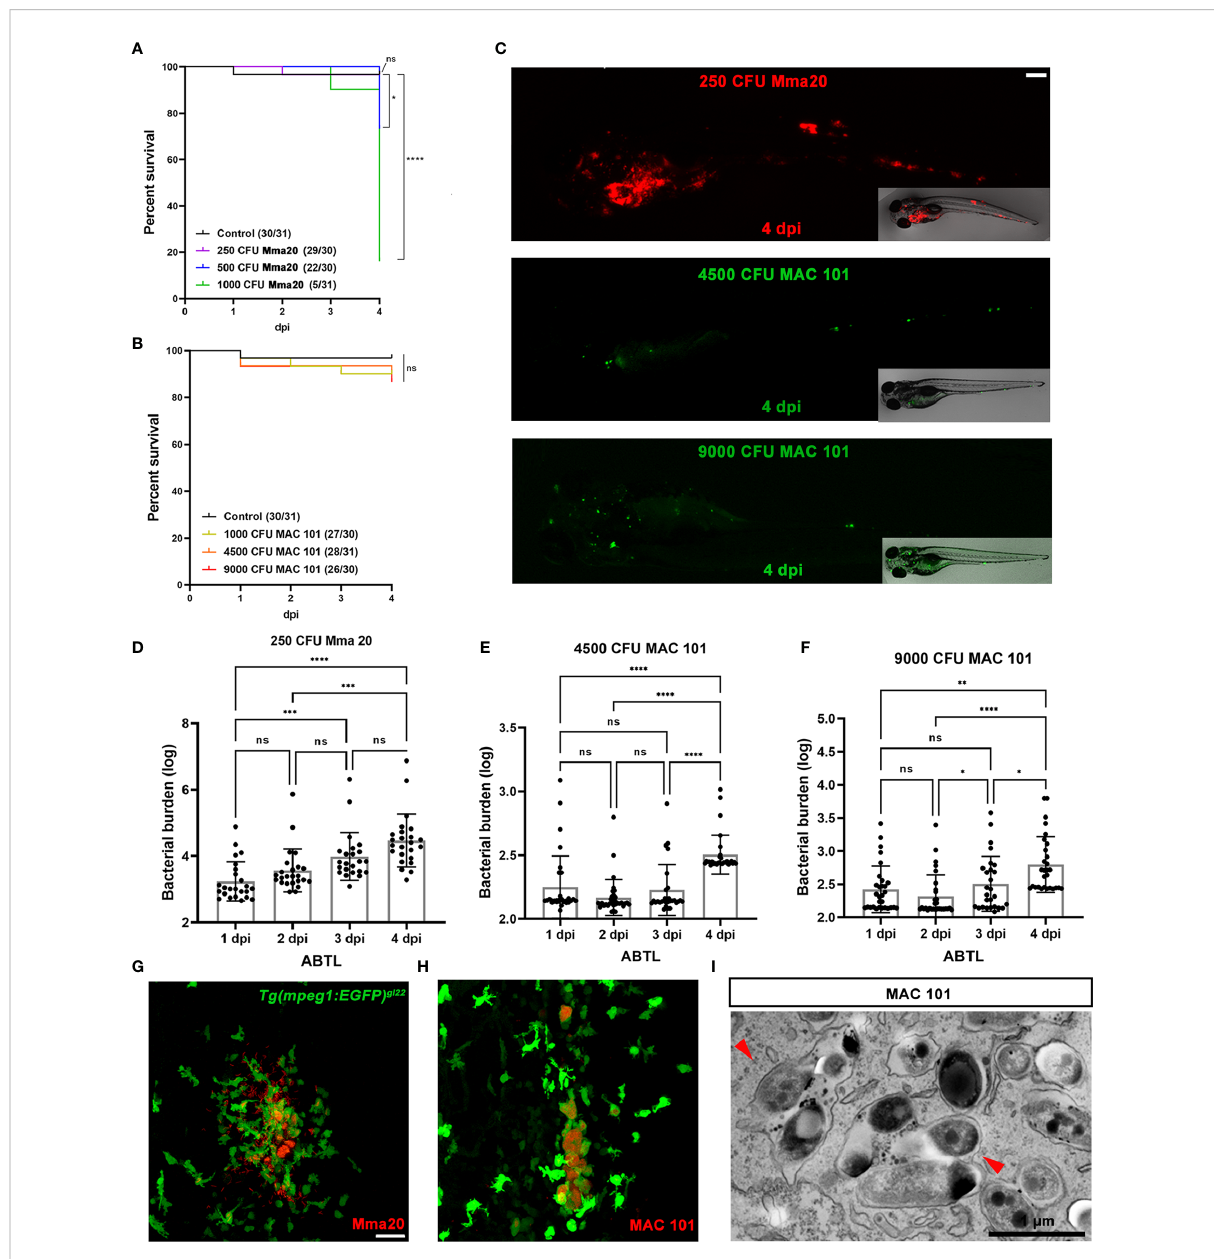
FIGURE 1 Characterization of M. avium infection in zebra fi sh larvae compared to M. marinum infection. (A, B) Percent of survival curves for ABTL zebra fi sh larvae infected with a series of doses M. marinum Mma20 or M. avium MAC 101. ABTL zebra fi sh larva infected with mCherry-labeled M. marinum Mma20 at a dose of ~250 CFU and infected with wasabi-labeled M. avium MAC 101 at a dose of ~4500 CFU or 9000 CFU by caudal vein infection at 28 hpf. (C) Representative images for the bacterial burden quanti fi cation were taken at 4 dpi. Scale bar: 50 µm. (D) Bacterial burden quanti fi cation of ABTL zebra fi sh larvae upon ~250 CFU Mma20 infection. (E) Bacterial burden quanti fi cation of ABTL zebra fi sh larvae upon ~4500 CFU MAC 101 infection. (F) Bacterial burden quanti fi cation of ABTL zebra fi sh larvae upon ~9000 CFU MAC 101 infection. (G, H) Representative CLSM images of Tg(mpeg1: EGFP) gl22 zebra fi sh larvae infected with mCherry-labeled Mma20 strain (G) or DsRed-labeled MAC 101 (H) . Tg(mpeg1: EGFP) gl22 embryos were infected ~250 CFU Mma20 mCherry strain or ~4500 CFU MAC 101 DsRed strain at 28 hpf. CLSM images were taken for the 4 dpi infected larvae by using 40 times magni fi cation lens (oil immersion, N.A. 1.3). Scale bar: 50 µm. (I) TEM pictures showing a sagittal section through MAC 101 in wild type zebra fi sh larva. Red arrows represent the bacteria inside of a phagocyte. Scale bar: 1 µm. In (A, B) data were collected from three pools of zebra fi sh larvae. In (D, E, and F) data (mean ± SD) were combined from three pools of zebra fi sh larvae. Statistical signi fi cance of differences was determined by using one-way ANOVA with Tukey ’ s multiple comparison test as a post-hoc test. * P < 0.05, ** P < 0.01, *** P < 0.001, **** P < 0.0001. Sample size (n): 24, 24, 23, 24 (D) , 31, 33, 31, 30 (E) , 30, 29, 27, 29 (F)